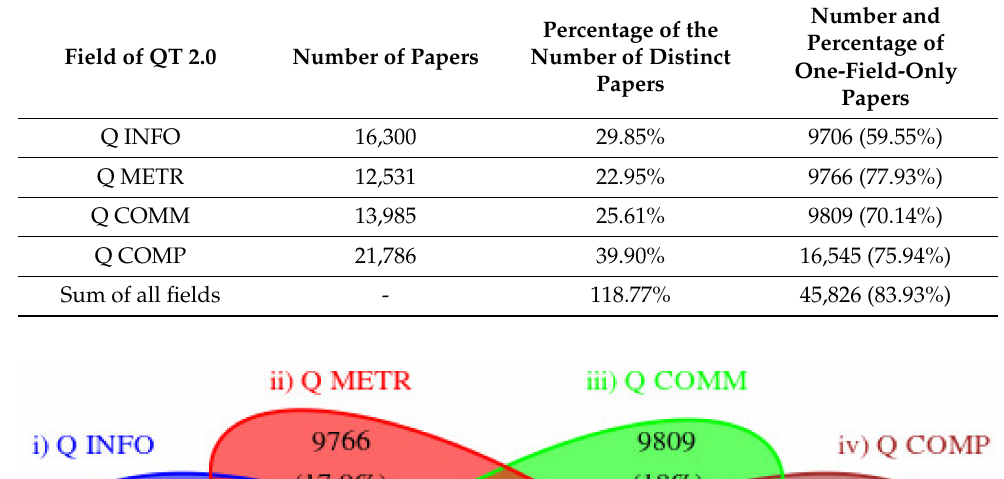
Table 1. Number and percentage of papers in four fields of QT 2.0.